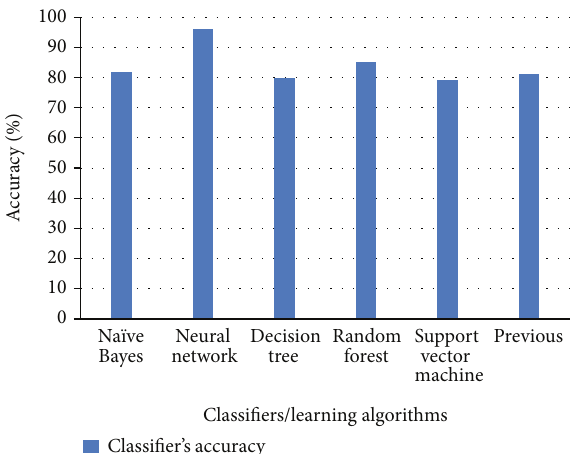
Figure 7: Comparison of each classifier’s classification accuracy using dataset